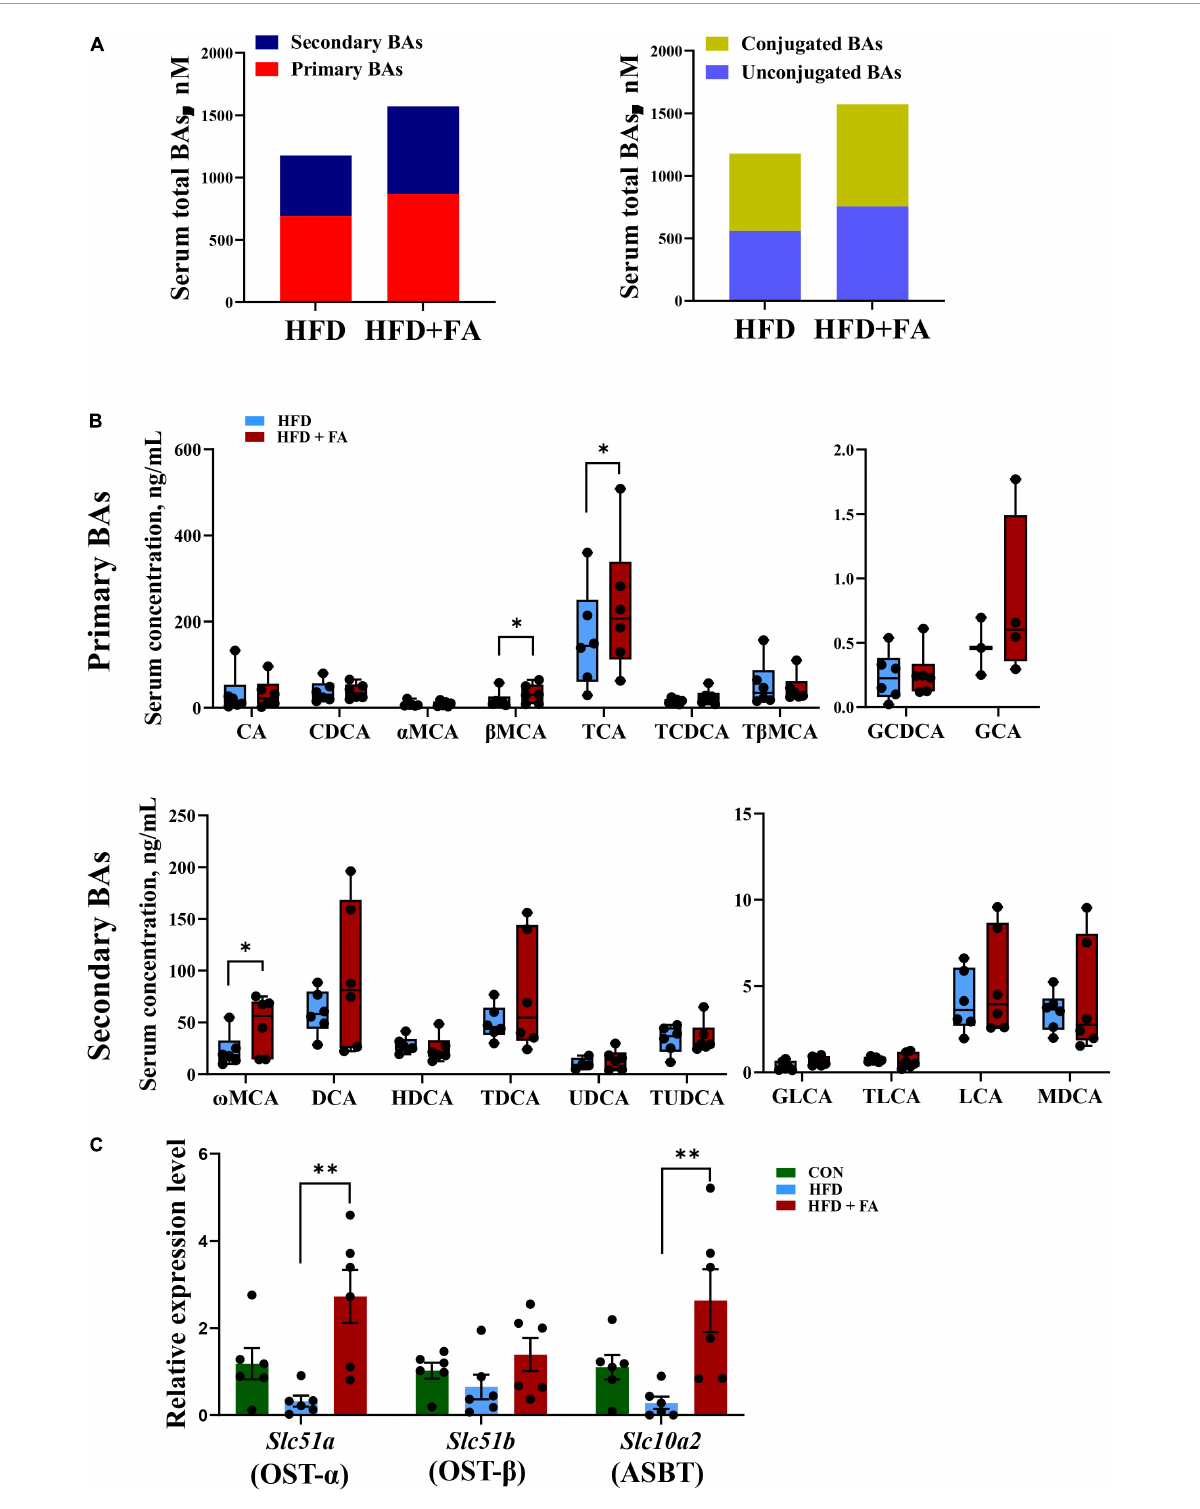
FIGURE4 FA supplementation increases BAs reabsorption. (A) Serum total pools of primary BAs, secondary BAs, conjugated BAs and unconjugated BAs in the HFD and HFD + FA mice. (B) Serum BAs profiles of 9 primary BAs and 10 secondary BAs in the HFD and HFD + FA mice ( n = 6). (C) The mRNA levels of OST α , OST β and ASBT in the ileum samples from the CON, HFD, and HFD + FA mice ( n = 6). Data are presented as mean ± SEM. ∗ p < 0.05, ∗∗ p < 0.01. CON, control diet group; HFD, high-fat diet group; HFD + FA, high-fat diet with 100 mg/kg bw/day FA